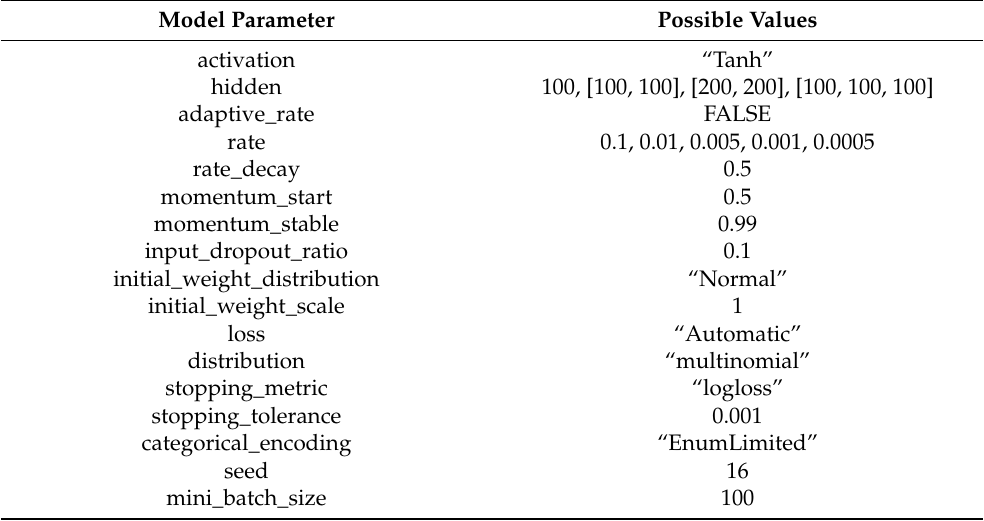
Table 9. Tuning Parameters for Deep Learning Frequency